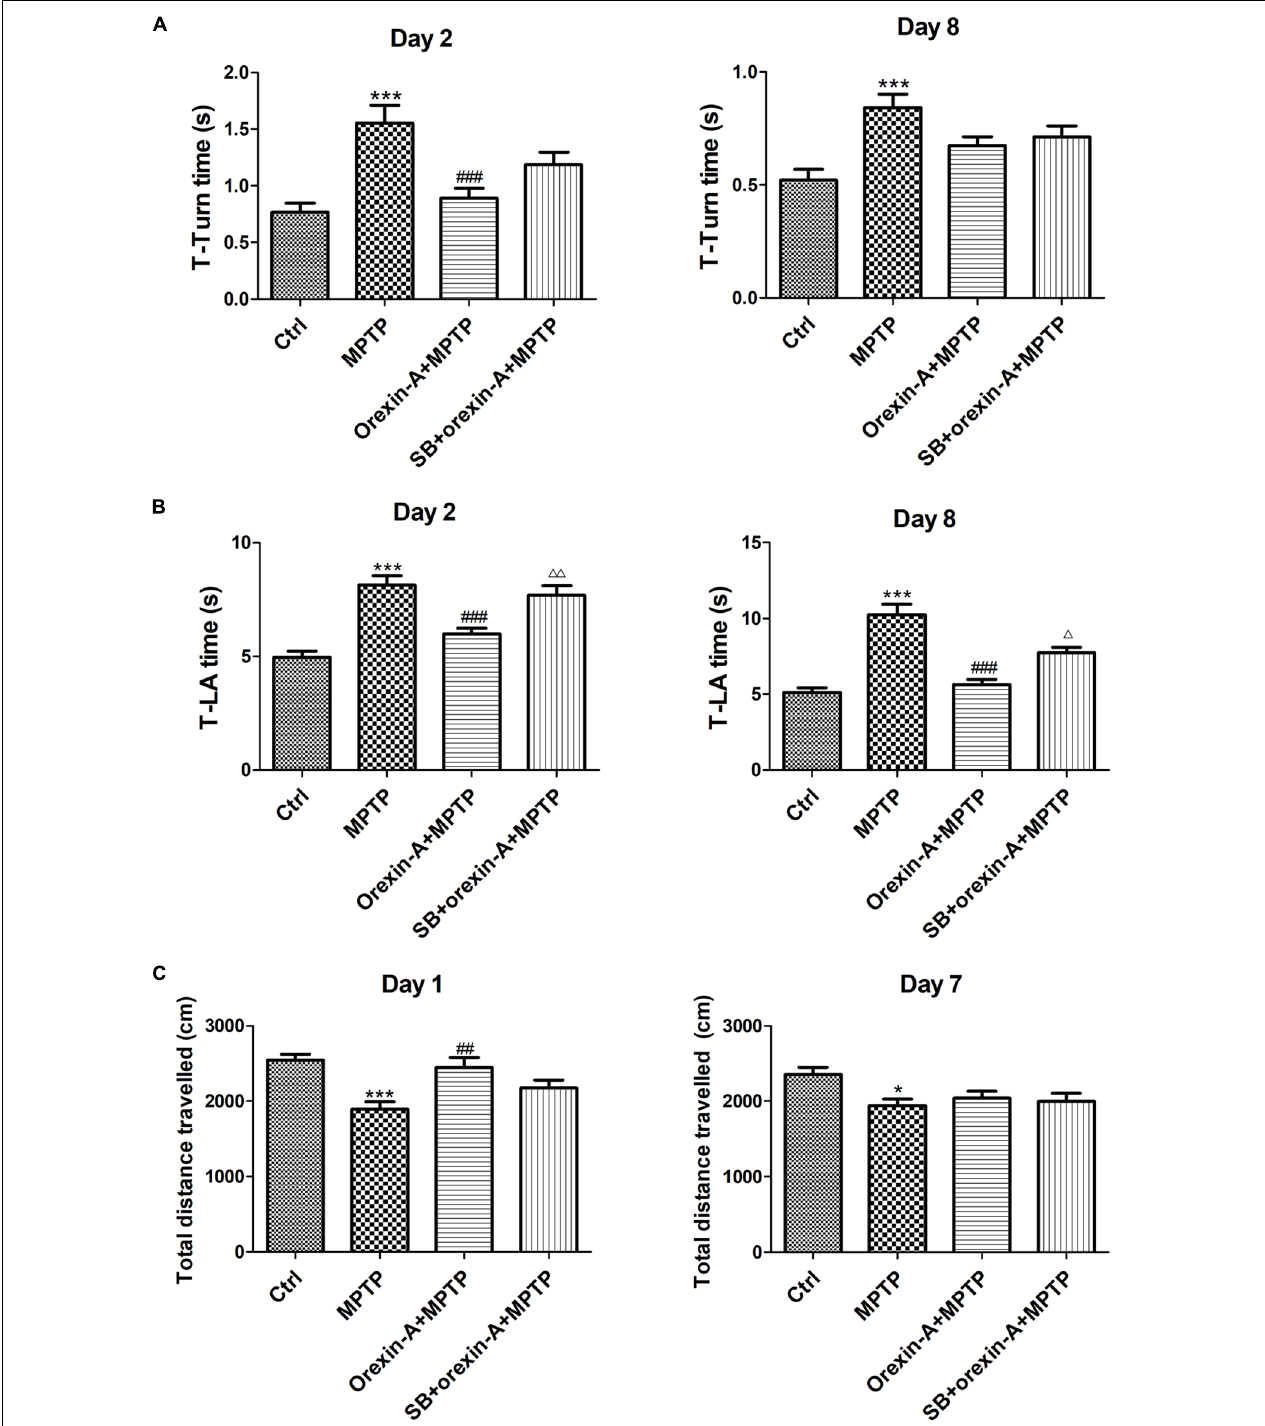
FIGURE 3 | Effects of orexin-A on the motor activity impairments induced by MPTP intoxication in pole test (A,B) and open field test (C) . T-turn time (A) and T-LA time (B) in pole test were recorded on day 2 and day 8 after the cease of MPTP treatment. (C) Total distance traveled in 10 min-duration open field test was recorded on day 1 and day 7 after the cease of MPTP treatment. Values were mean ± SEM, n = 12–14. ∗ P < 0.05, ∗∗∗ P < 0.001 vs. control; ## P < 0.01, ### P < 0.001 vs. MPTP; (cid:49) P < 0.05, (cid:49)(cid:49) P < 0.01 vs. orexin-A + MPTP. SB: SB334867.